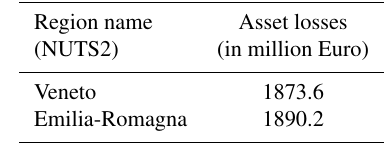
Table 4. Total economic losses in Italy (in million Euro).